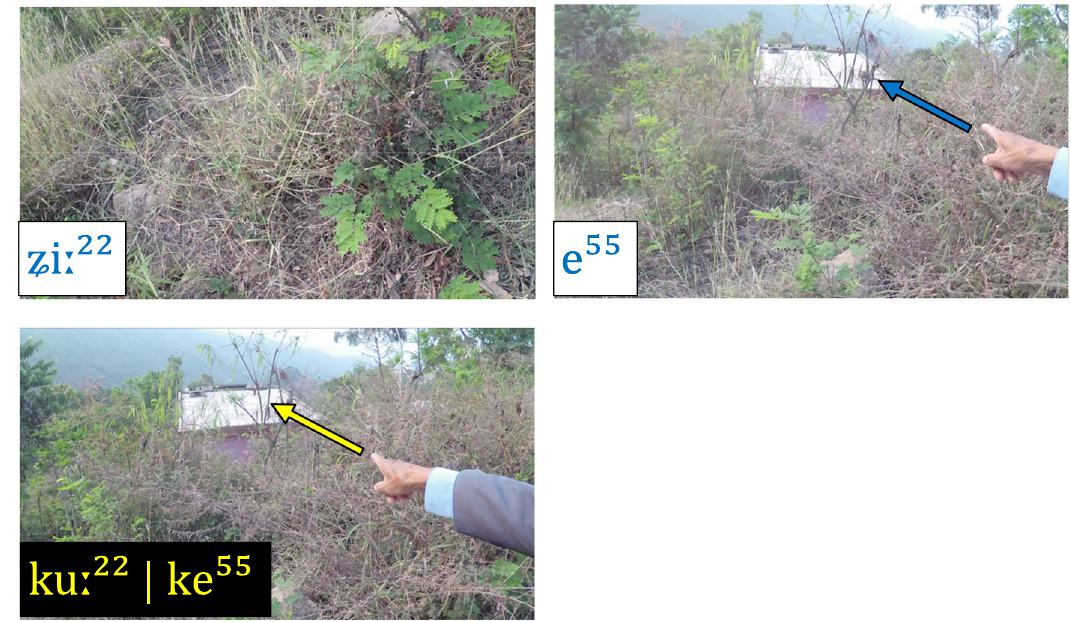
Figure 15: Speaker draws attention towards a tree using speaker and downhill